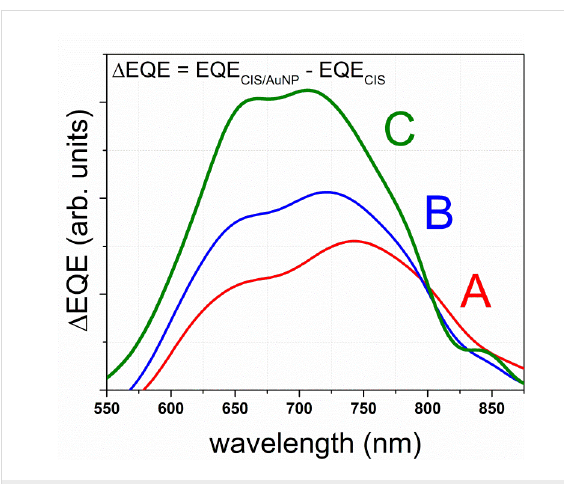
Figure 4: Spectra of the relative increase in ∆ EQE for the ITO/ ZnO/In 2 S 3 /CuInS 2 /Au-NP solar cells when compared to the EQE of the solar cells without the Au-NP layer. The ∆ EQE curves A, B and C corresponds to the EQE data presented in Figure 3A, B and C, res- pectively.